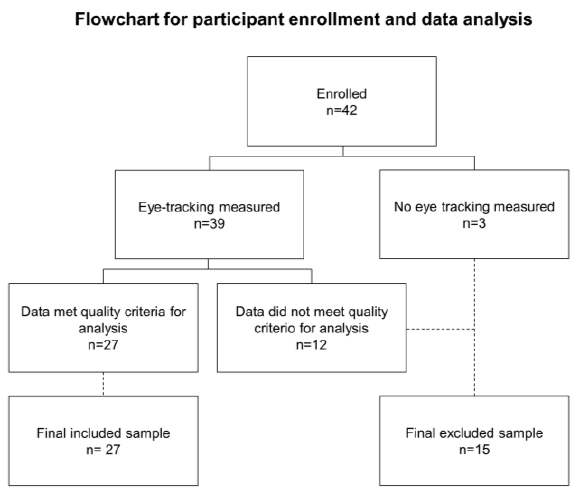
Figure 3. Flowchart for participant enrollment and data analysis.